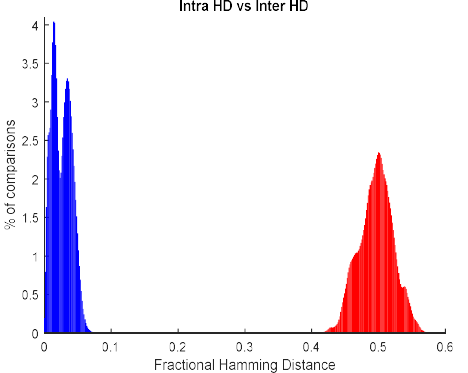
Figure 4. Fractional Hamming Distances obtained from the PUF responses considering only ID cells.